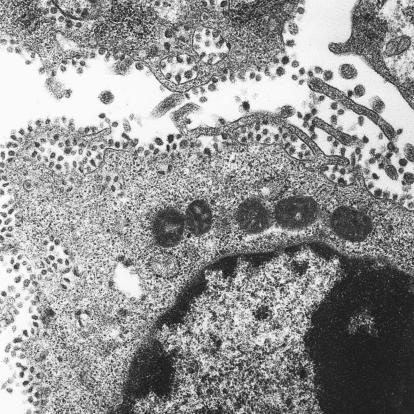
An electron micrograph of SARS-CoV-infected Vero cells